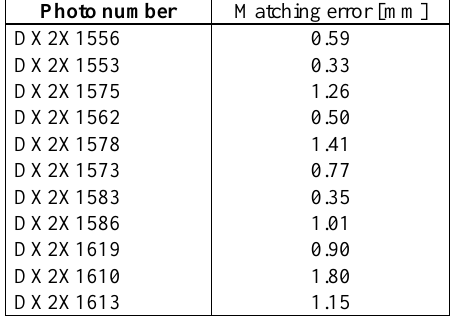
Table 1. Results of image and point cloud matching